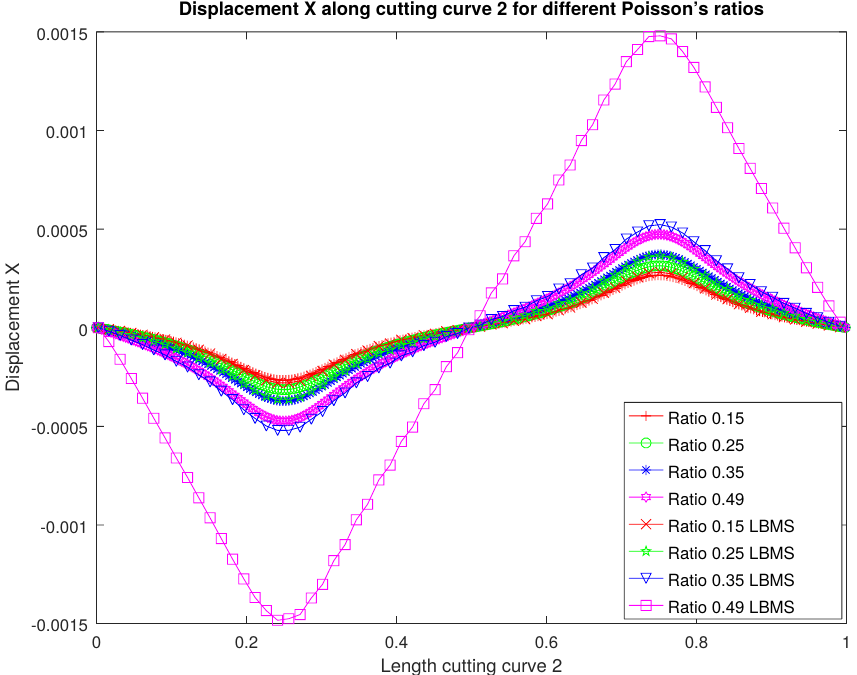
Figure A7. First displacement components along cutting curve C 2 for positive Poisson’s ratios.